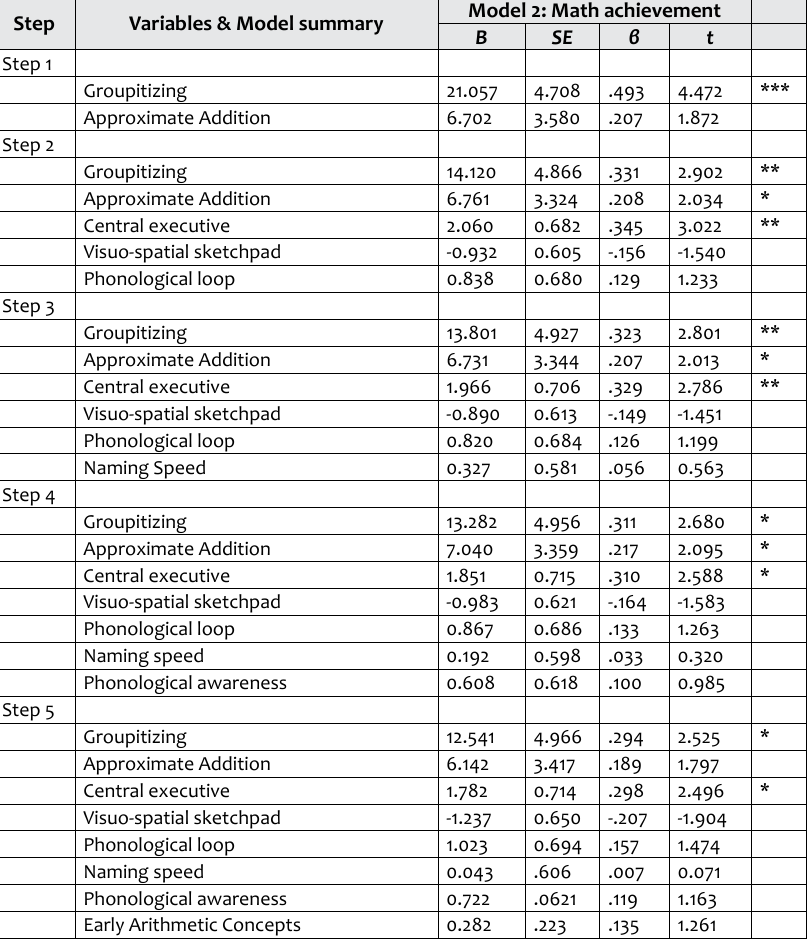
Table 5: Regression analyses of 2 nd grade math achievement: unique